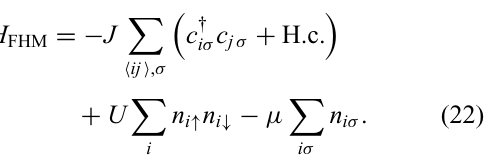
(cid:14) (cid:13) in the z N / 2 z j